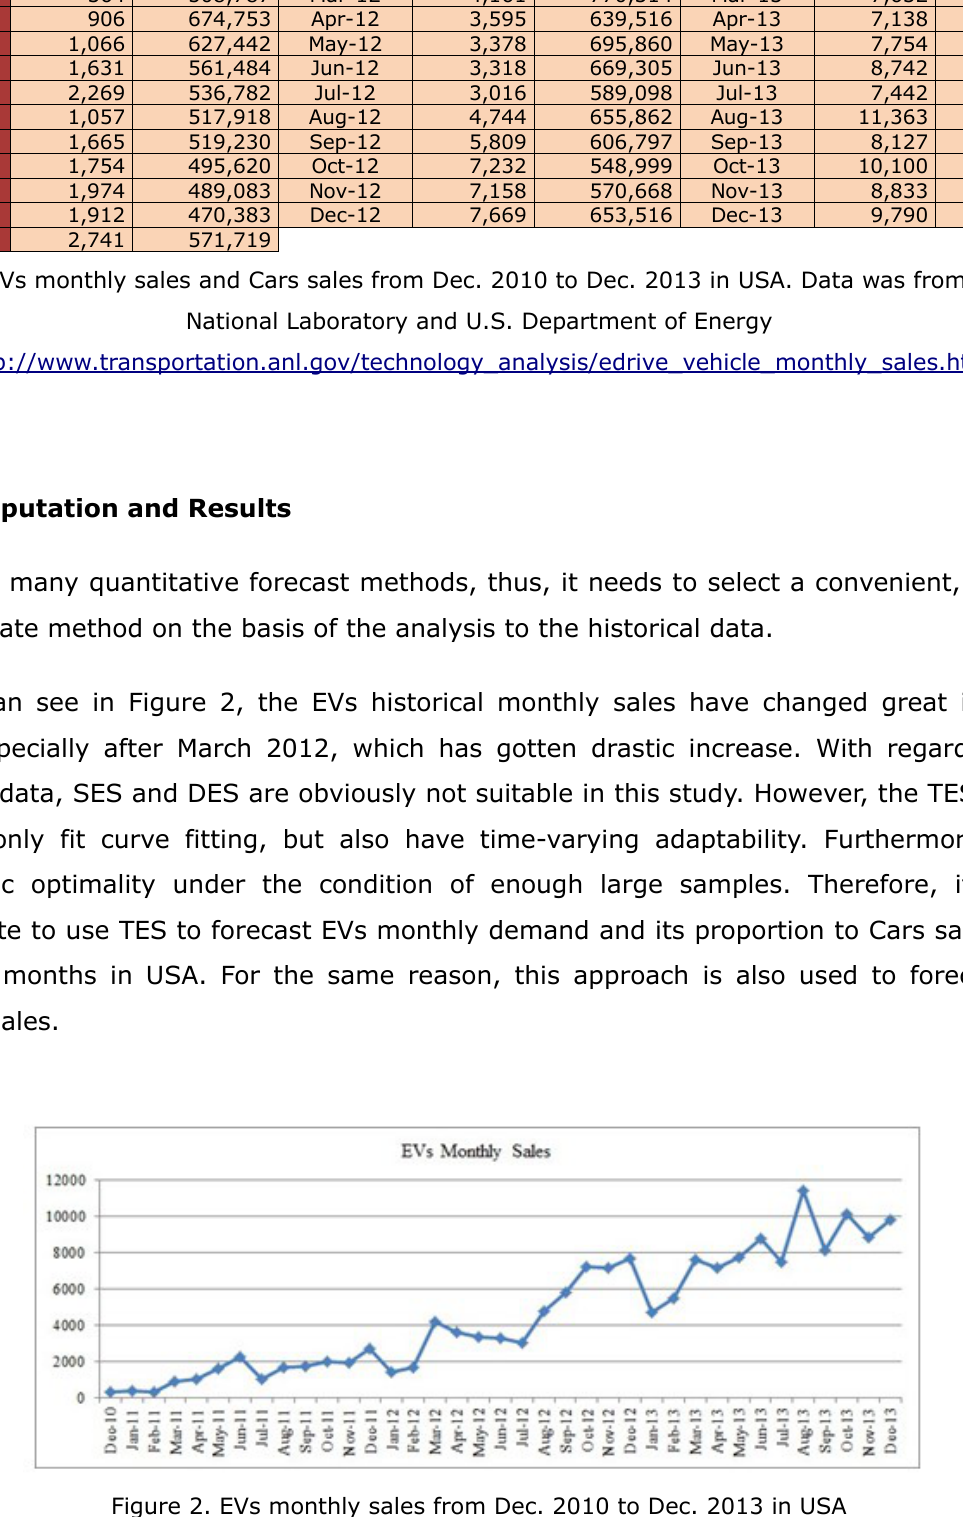
Figure 2. EVs monthly sales from Dec. 2010 to Dec. 2013 in